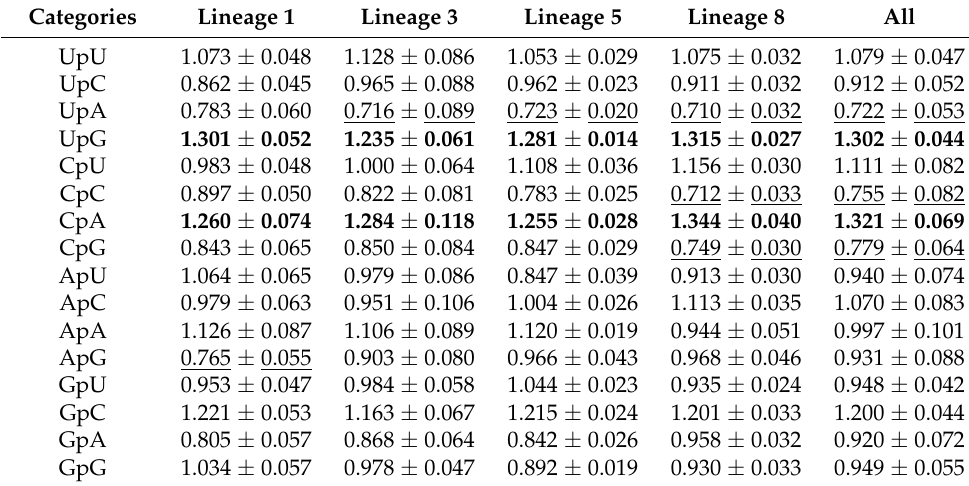
Figure 2. Dinucleotide abundance of ORF5 genes from Chinese PRRSV strains. Dinucleotides are regarded as underrepresented or overrepresented if the relative abundance values are below 0.78 or above 1.23 (dashed lines), respectively. Table 2. Dinucleotide relative abundance of PRRSV ORF5 genes from Chinese strains analyzed in this study (mean value ±